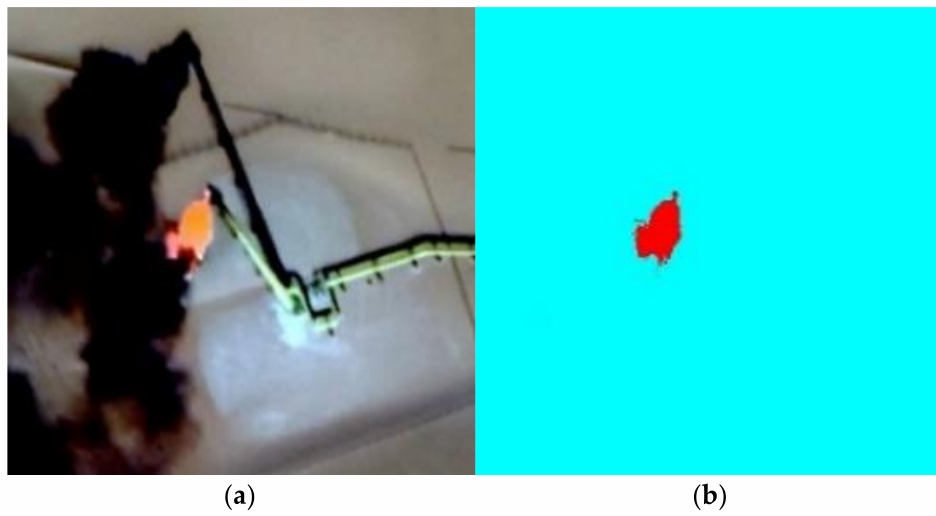
Figure 5. ( a ) The considered real RGB data covering a flare area. ( b ) The corresponding two-class classification.